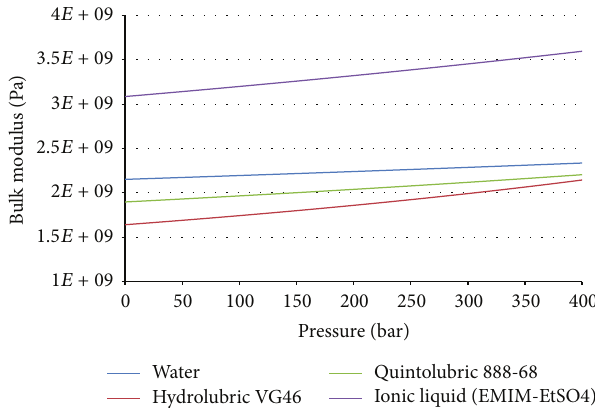
Figure 8: Measured bulk modulus versus pressure for all three considered fluids.